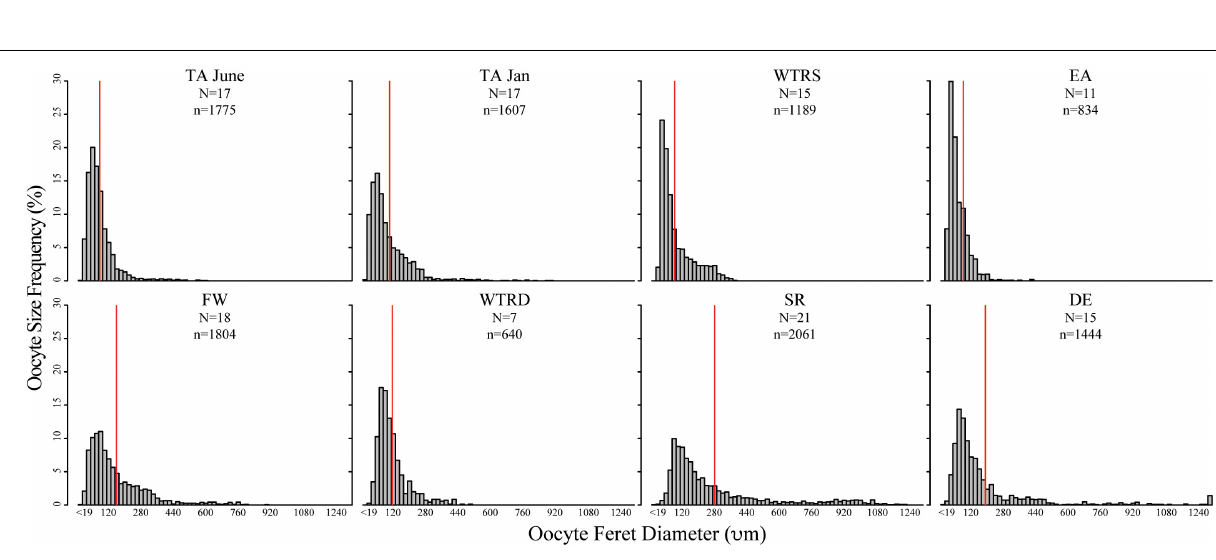
Frontiers in Marine Science |